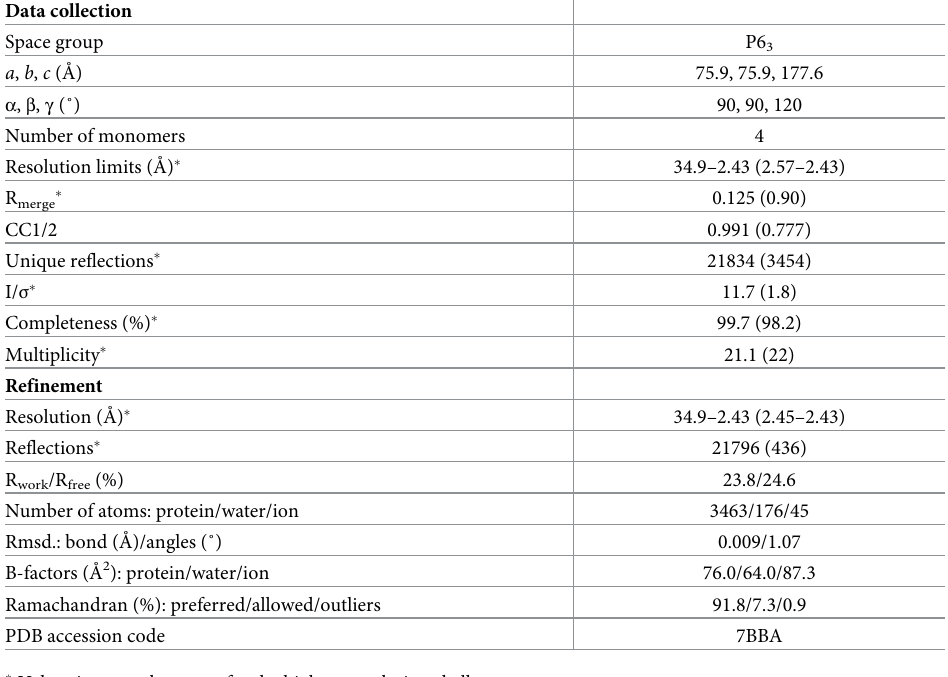
Table 1. Data collection and refinement statistics of the TagL peptidoglycan binding domain (PGBD).